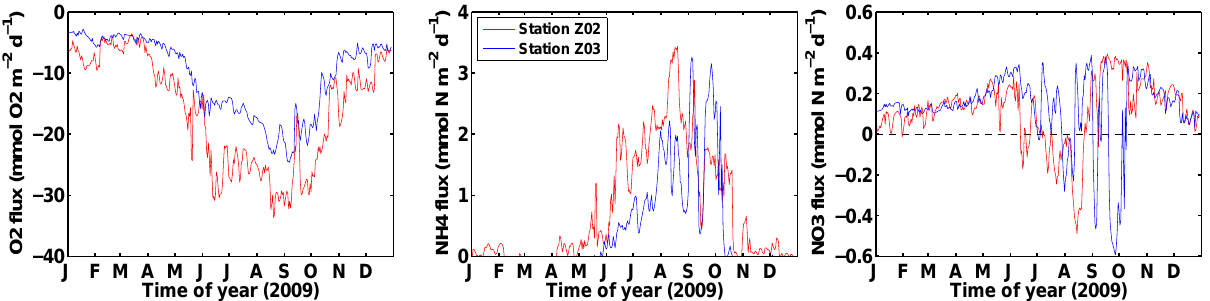
and NO − fluxes at stations Z02 and Z03 in 2009. Negative fluxes are into the 4 3